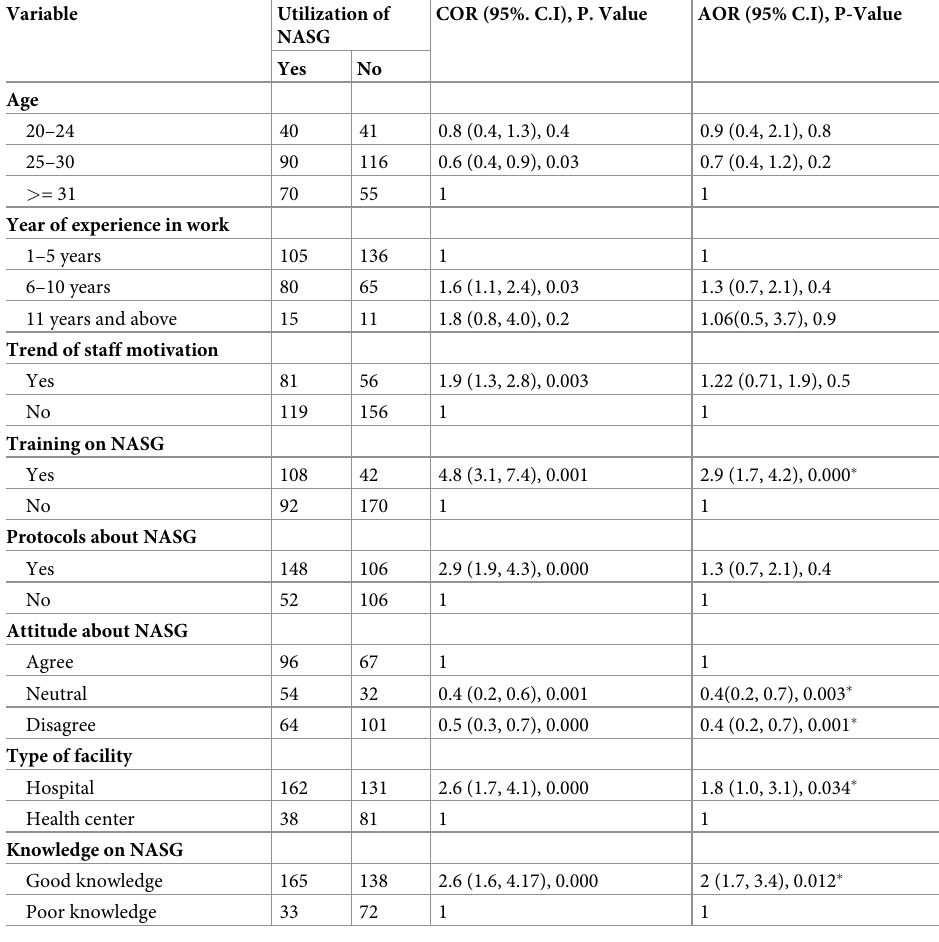
Table 6. Factors associated with the utilization of non-pneumatic antishock garment among obstetric care pro- viders in public health facilities of Southern Ethiopia, 2020.